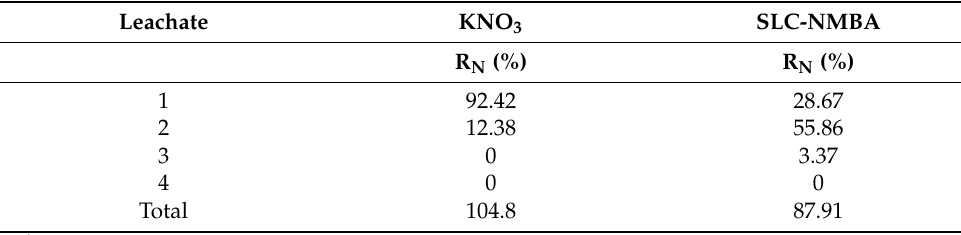
Table 9. Nitrate leached percentage obtained in the dynamic study a